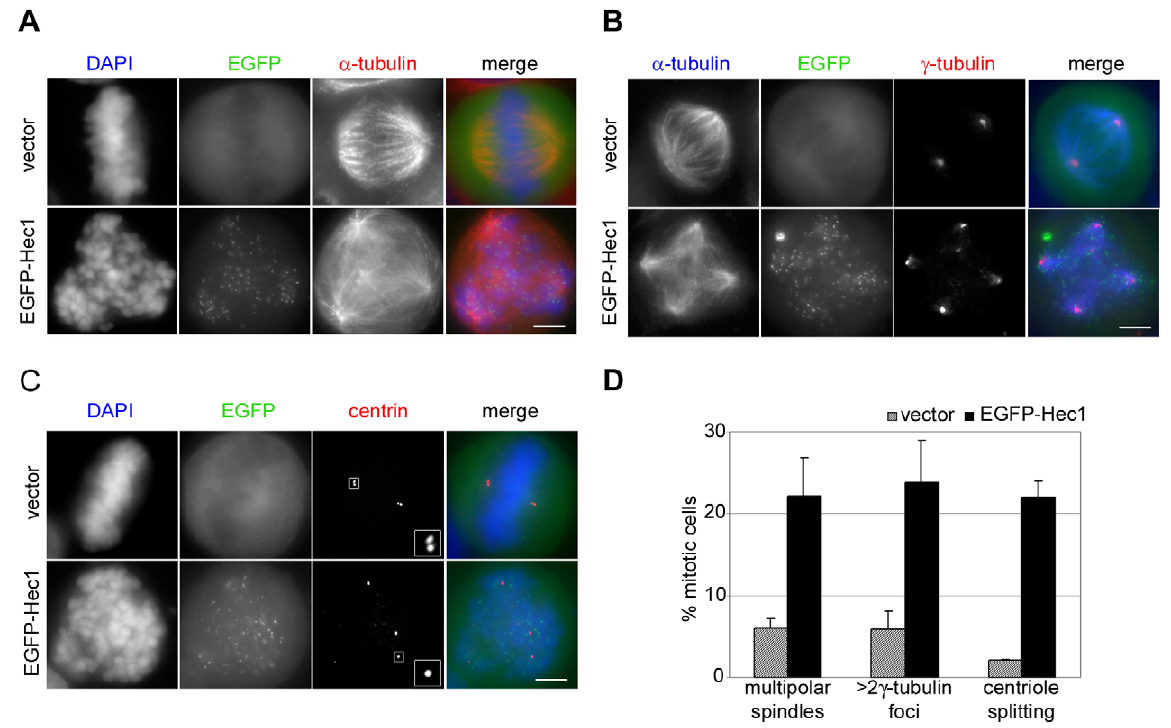
Figure 3. EGFP-Hec1 expression induces multipolar spindles and centrosomal abnormalities. (A) Vector or EGFP-Hec1 (green) transfected cells stained for a -tubulin (red) and DAPI (blue). The EGFP-Hec1 disorganized prometaphase exhibited a multipolar spindle. (B) Vector or EGFP-Hec1 (green) transfected cells stained with antibodies to a -tubulin (blue) and c -tubulin (red). 5 c -tubulin spots connected to spindle microtubules were present in the EGFP-Hec1 cell. (C) Vector or EGFP-Hec1 (green) transfected cells stained with antibodies to centrin (red). The boxed 3-fold enlargements show a centriole pair in the vector-transfected metaphase and one single centriole in the EGFP-Hec1 disorganized prometaphase. (D) Mean percentage ( 6 SE) of multipolar spindles detected by a -tubulin staining (n=300 from triplicate assays), . 2 c -tubulin foci (n . 200 from triplicate assays) and centriole splitting (n=200 from duplicate assays) in vector and EGFP-Hec1 transfected mitoses. Multipolar spindles ( a -and c -tubulin staining, P , 0.05, t-test) and splitted centrioles (P , 0.01, t-test) were significantly higher in EGFP-Hec1 expressing mitoses than in vector cells. Bars, 5 m m.